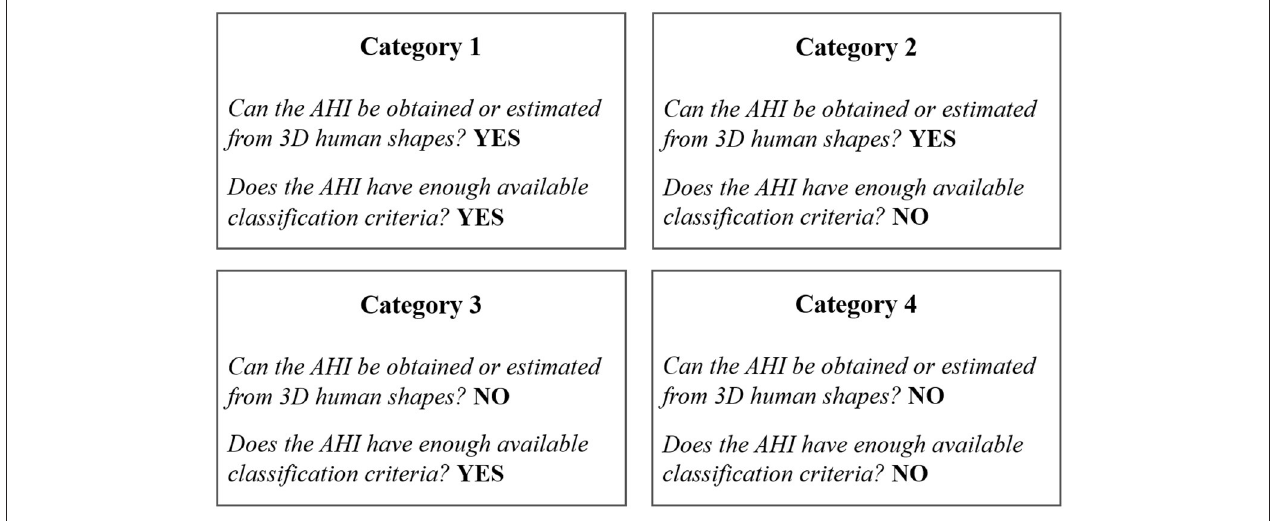
FIGURE 1 | Classification of AHIs into four